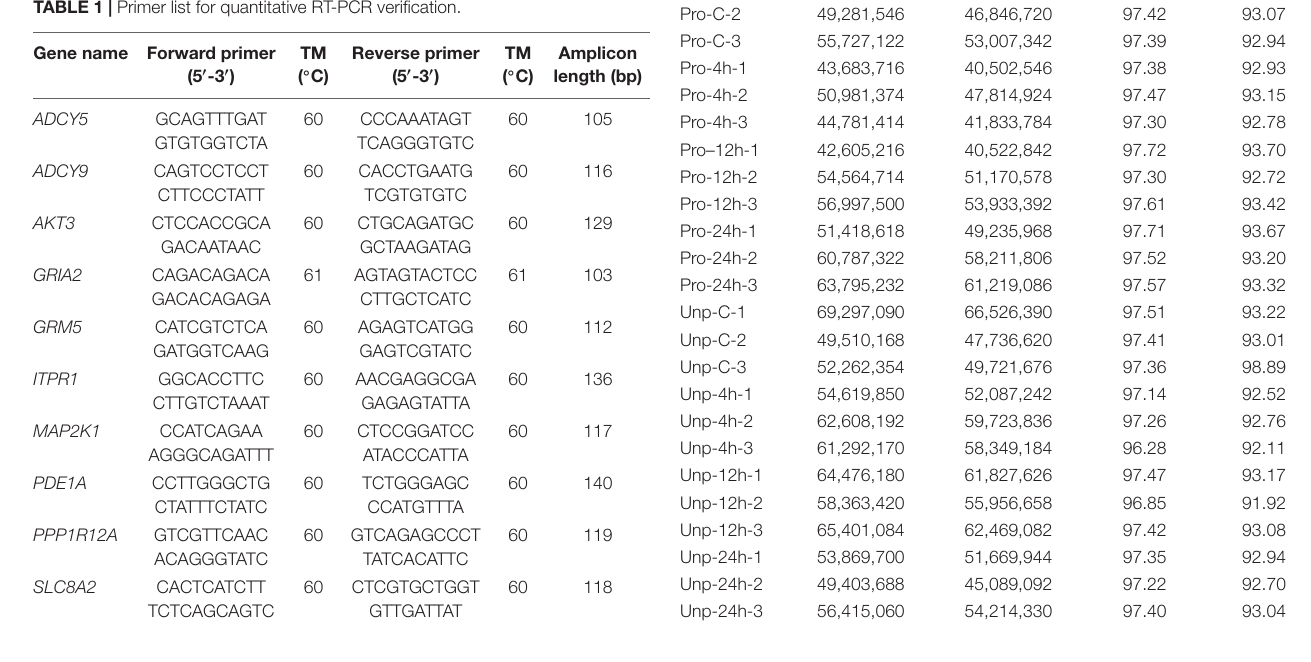
TABLE 1 | Primer list for quantitative RT-PCR